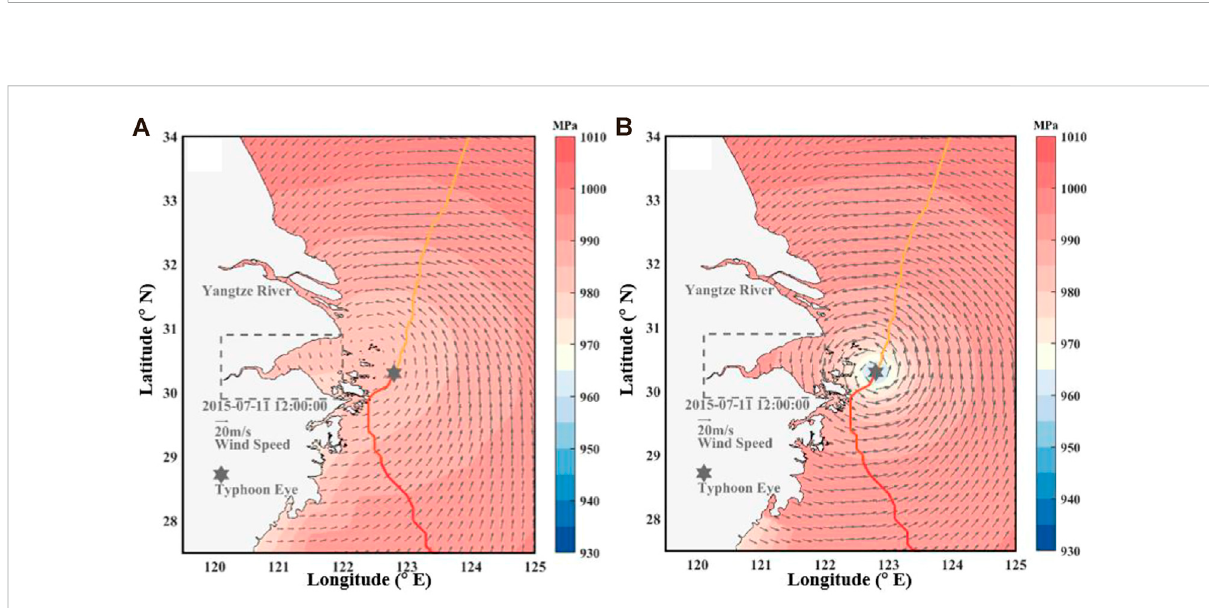
FIGURE 3 Comparison of (A) ECMWF and (B) synthetic wind fi eld distribution (11 July 2015,